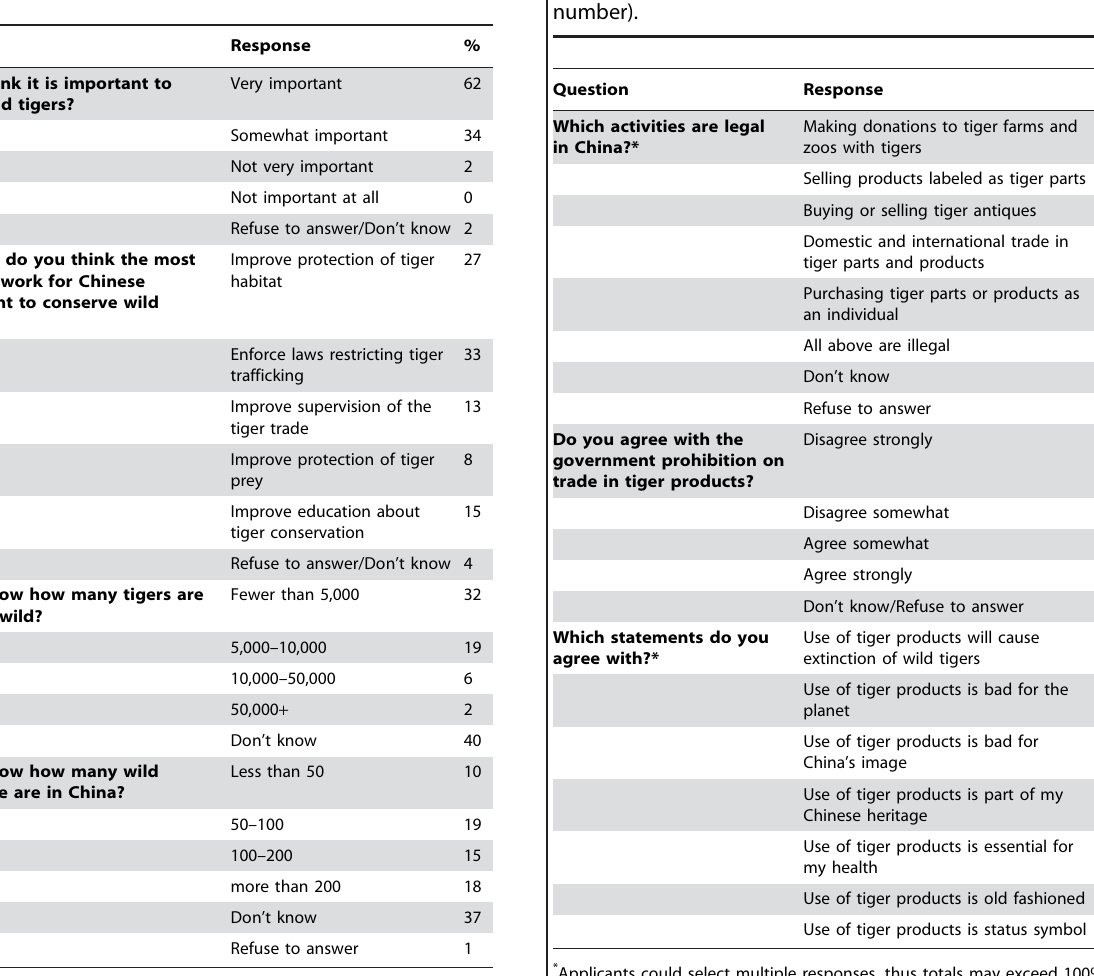
Table 3. Attitudes and knowledge of tiger conservation issues in Chinese cities (N=1880, % rounded to nearest whole number). Table 4. Attitudes and knowledge of tiger trade issues in